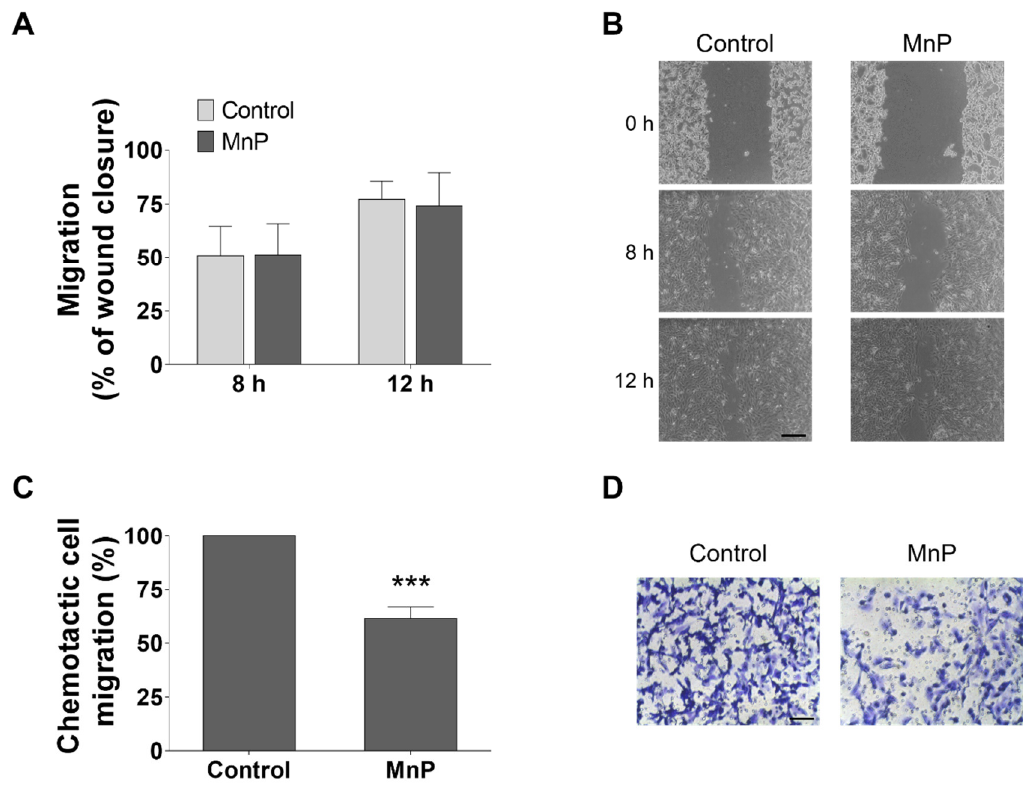
Figure 6. E ff ect of MnP treatment (0.25 µ M) on 786-O cell motility. Collective cell migration was Figure 6. Effect of MnP treatment (0.25 μM) on 786-O cell motility. Collective cell migration was evaluated by the wound-healing assay ( A , B ) and chemotaxis was measured using a transwell assay evaluated by the wound-healing assay ( A and B ) and chemotaxis was measured using a transwell ( C , D , 12 h). Representative microscopy images ( B , D ). Scale bars 200 µ m ( B ) and 80 µ m ( D ). Values assay ( C and D , 12 h). Representative microscopy images ( B and D ). Scale bars 200 μm (B) and 80 μm represent mean ± SD (n = 3), *** p < 0.001 (Student’s (D). Values represent mean ± SD (n = 3), *** p < 0.001 (Student’s t-test).